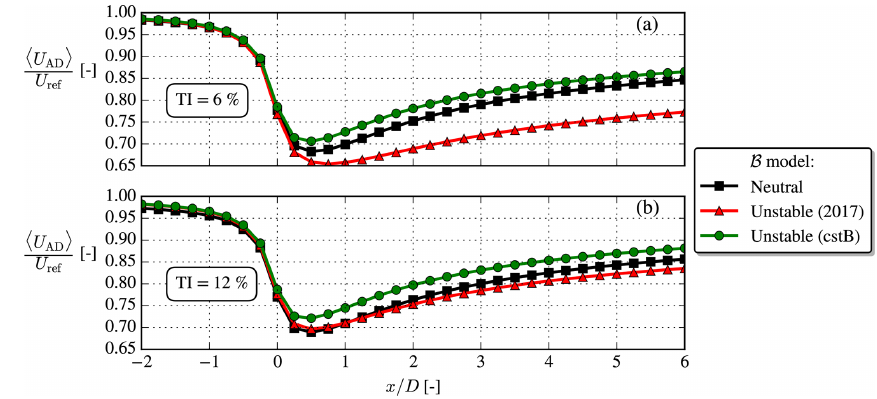
Figure 6. Disk-averaged streamwise velocity, (cid:104) U AD (cid:105) , for low/high TI and neutral/unstable. ζ ref = − 0 . 5 for unstable.